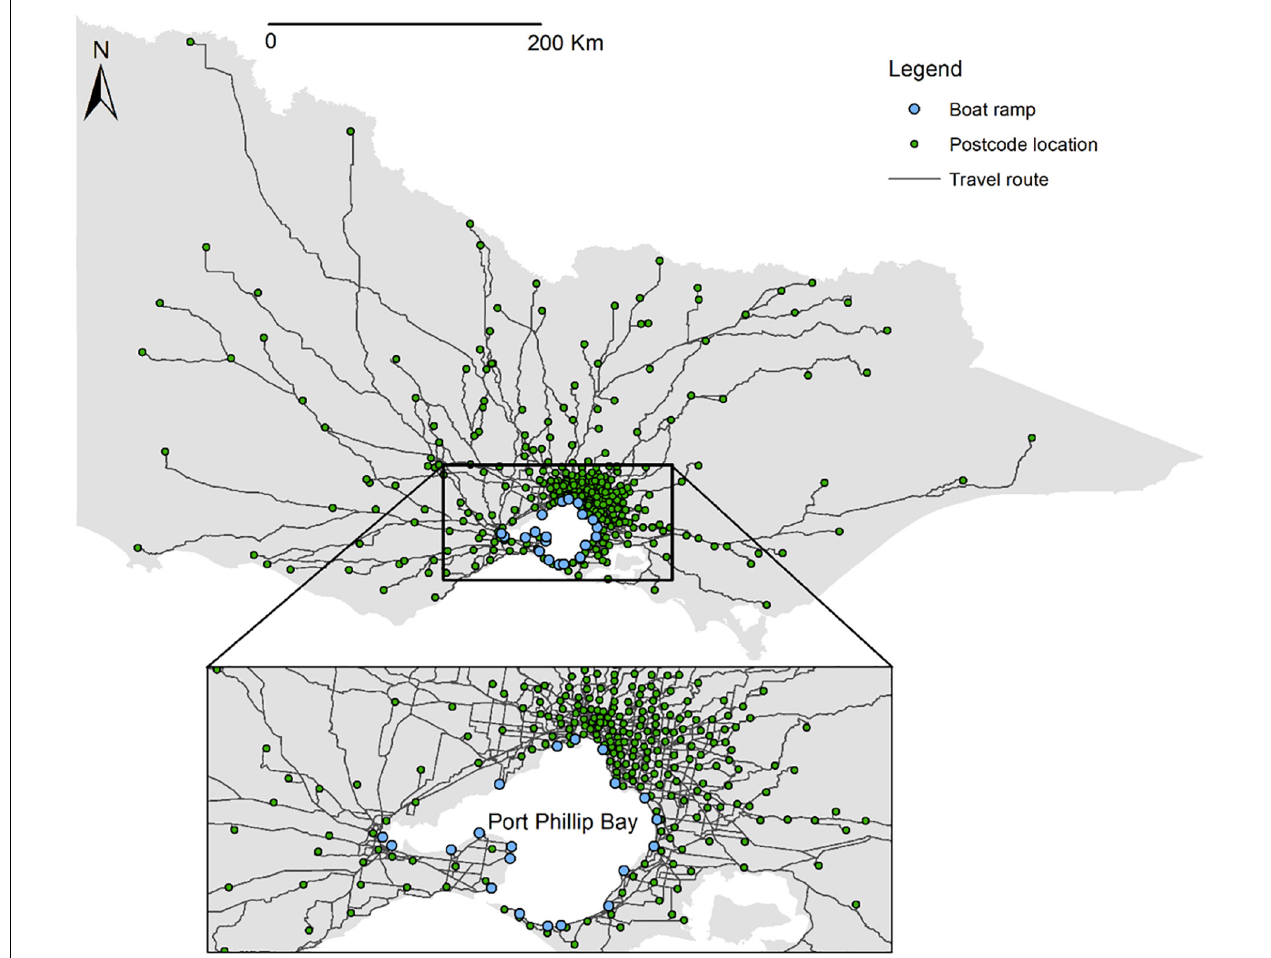
FIGURE 5 | Map showing land travel routes modeled using network analyst from residential postcodes of anglers to boat ramps throughout the State of Victoria. Data were pooled among species and years. Zoom box is drawn over Port Phillip